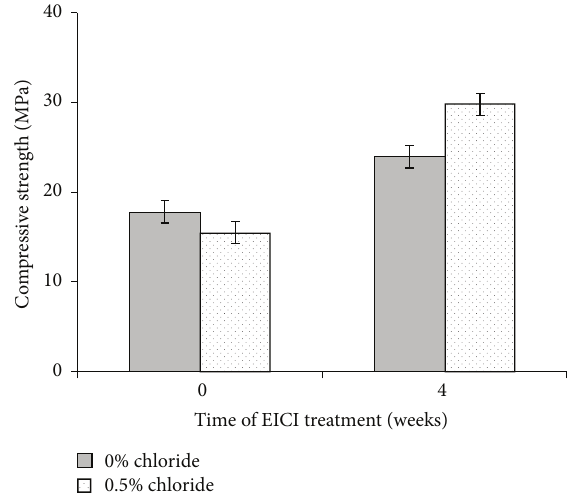
Figure 8: Compressive strength of cement mortar before and after EICI treatment in sodium borate